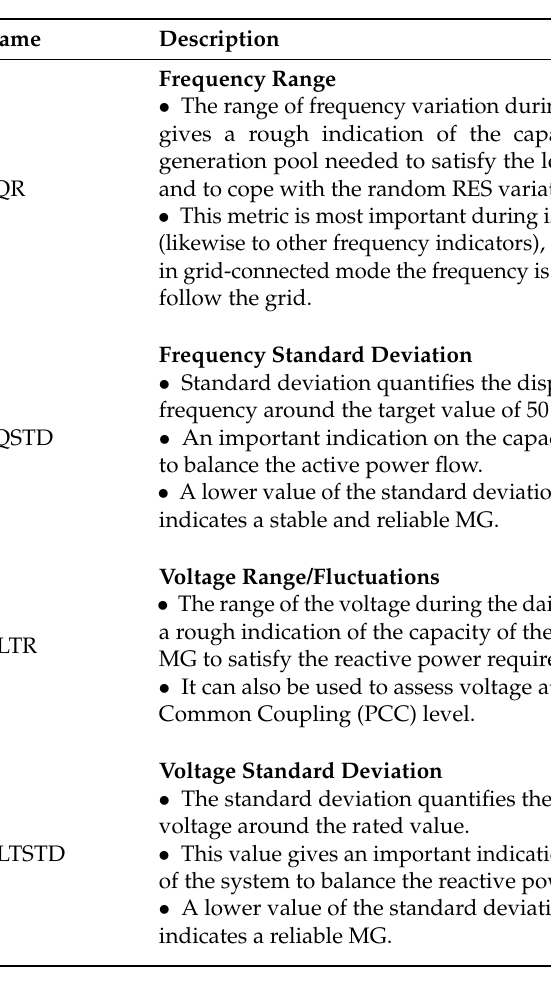
Table A5. Detailed Representation of MG Power Quality